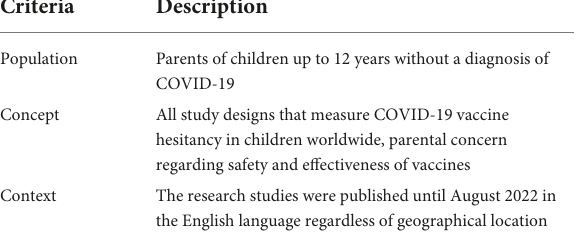
TABLE 1 PCC (Population, Concept, Context) framework to identify main concepts in review